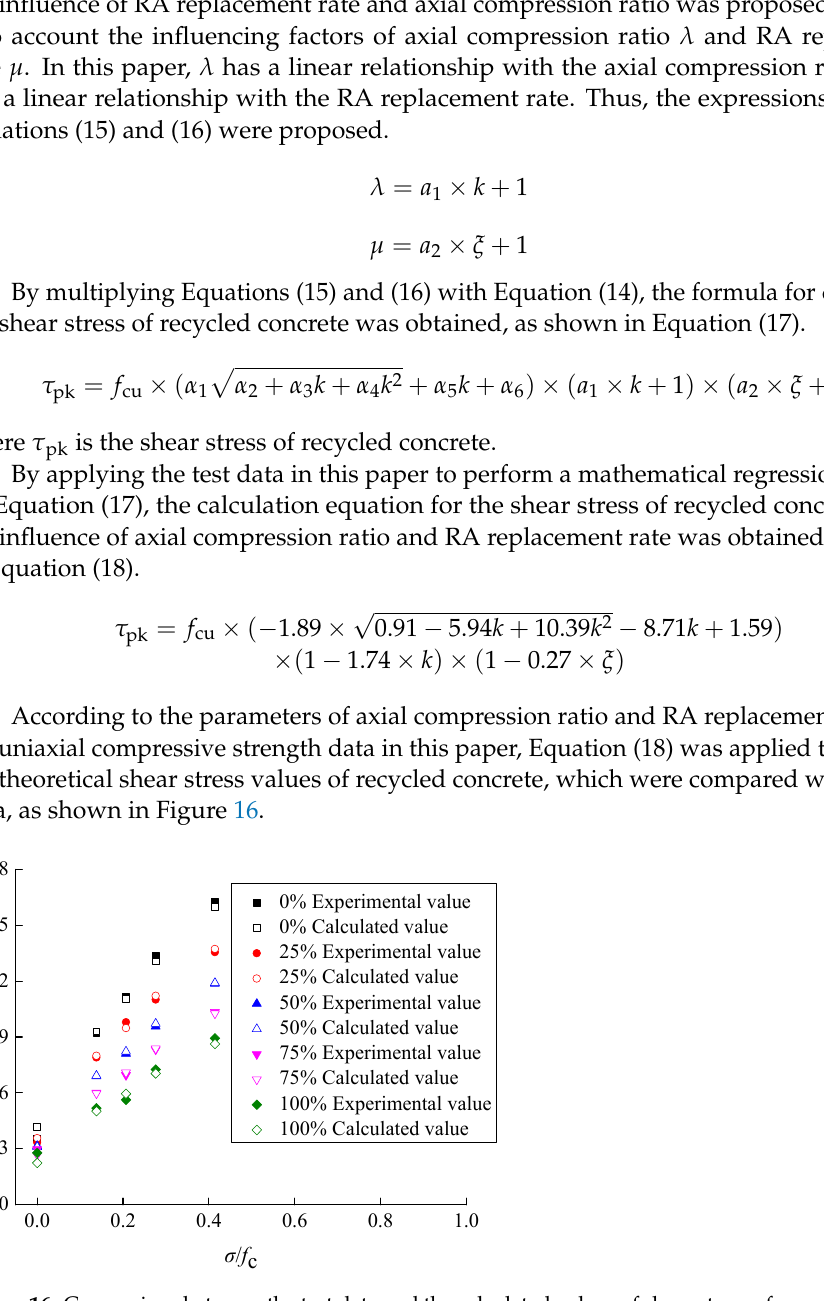
Figure 16. Comparison between the test data and the calculated values of shear stress of recycled concrete